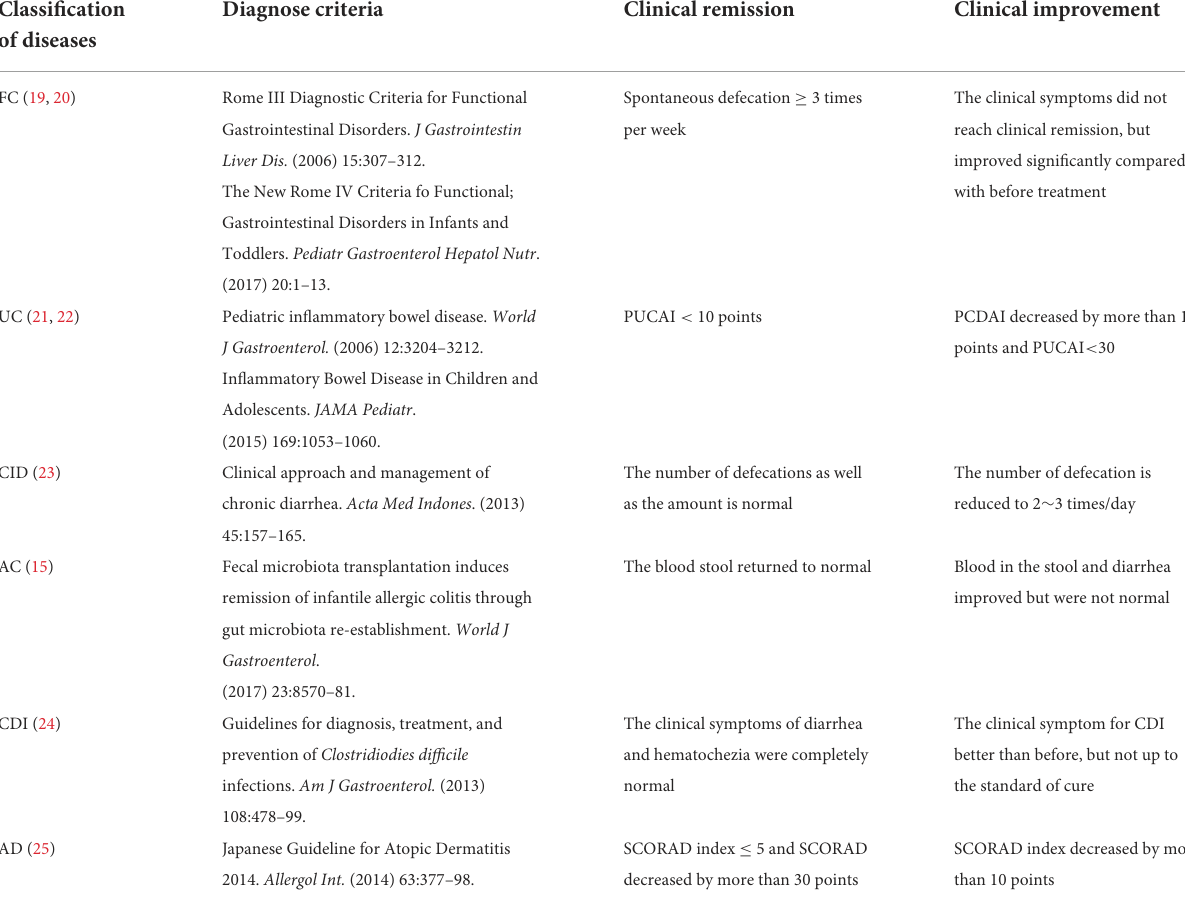
TABLE 1 The diagnostic criteria and curative effect evaluation of different diseases in patients enrolled in this